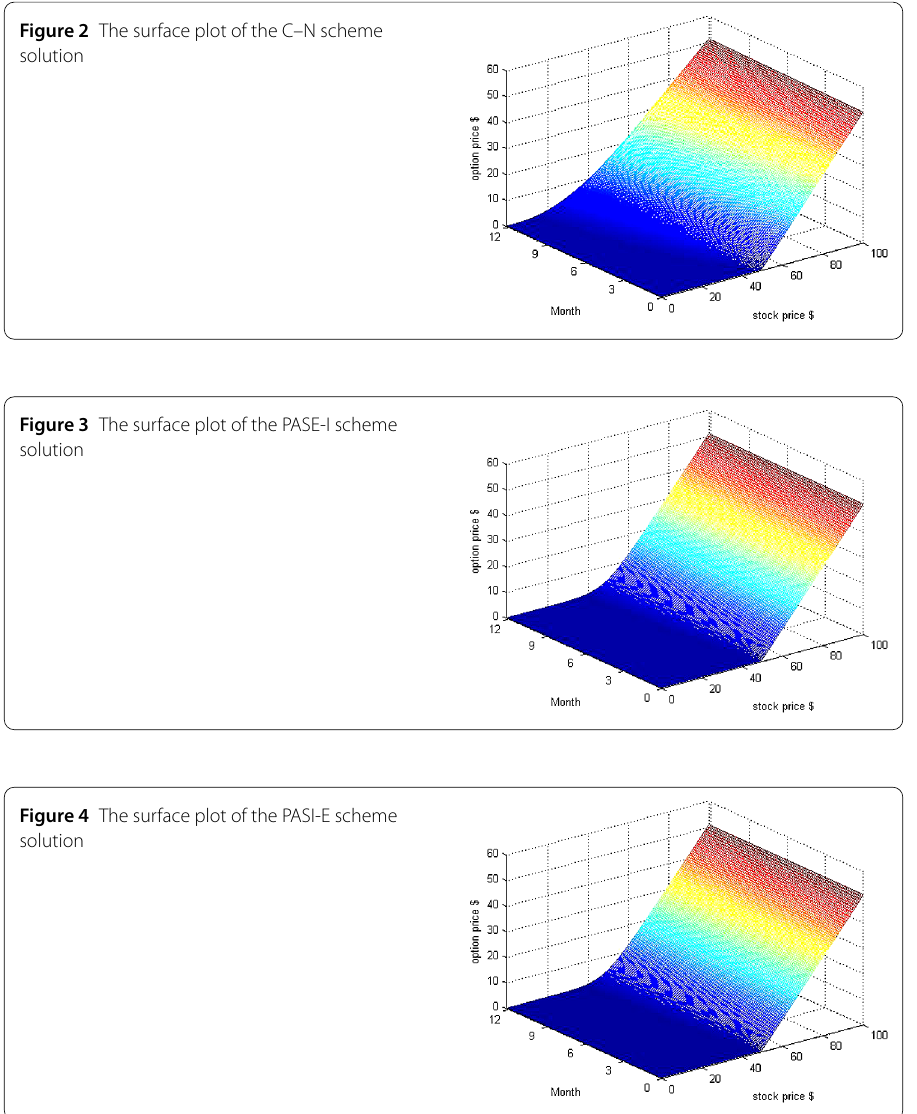
Figure 2 The surface plot of the C–N scheme solution